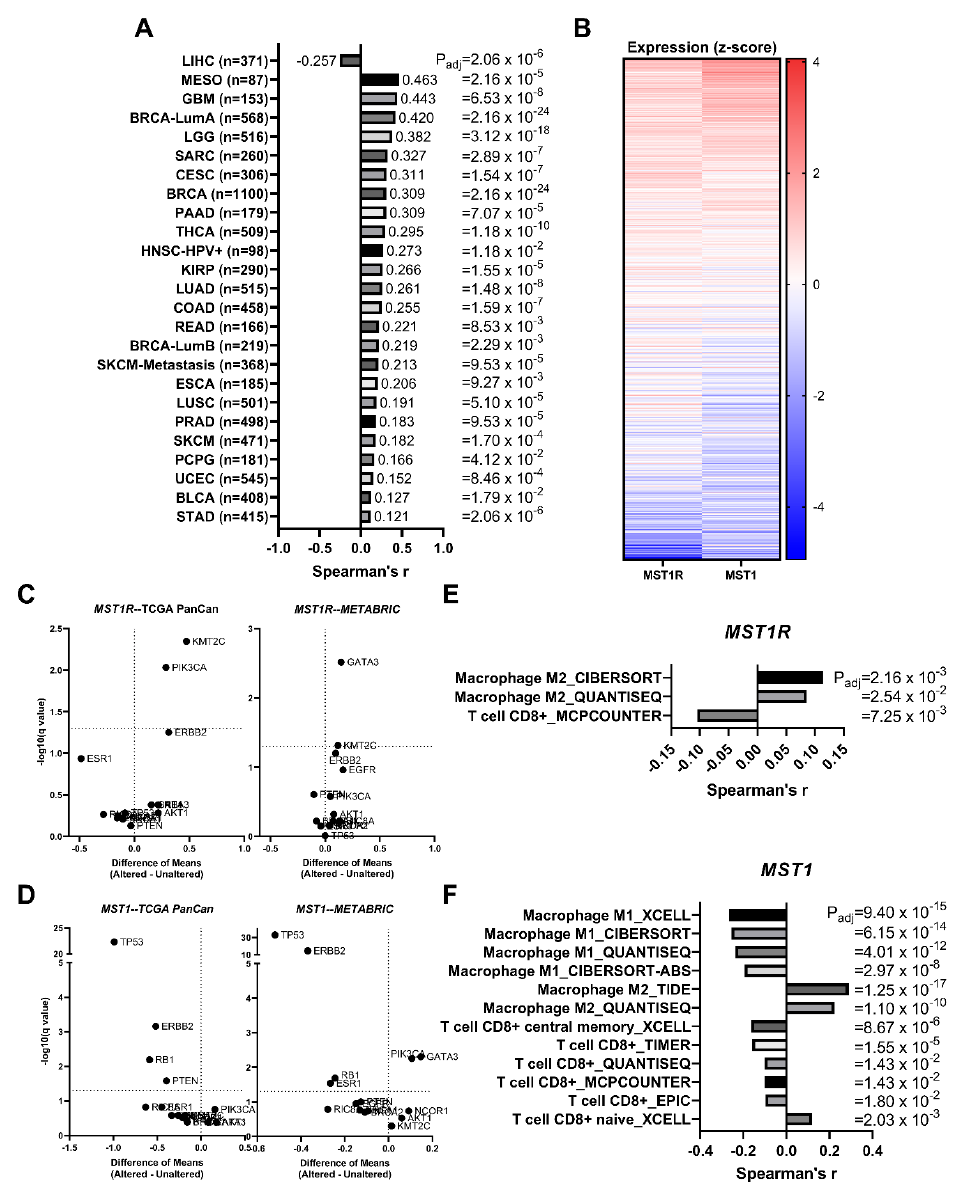
Figure 6. RON ( MST1R ) and HGFL ( MST1 ) expression are correlated in virtually all tumor types and expression is not associated with recurrent breast cancer driver mutations. ( A ) MST1R and MST1 gene expression are coordinately upregulated across specified cancer types from The Cancer Genome Atlas (TCGA) evaluated with Spearman’s correlation. ( B ) MST1R and MST1 RNA expression from TCGA showing coordinate expression in heatmap form. Volcano plots of ( C ) MST1R and ( D ) MST1 RNA expression stratified between Altered and Unaltered samples of listed recurrent breast cancer driver mutations from TCGA Pan-Cancer and METABRIC datasets were evaluated using Multiple t -tests on log-transformed expression values. Significant correlations of specified immune cell infiltration signatures with ( E ) MST1R and ( F ) MST1 gene expression using the tumor immune microenvironment estimation resource (TIMER) in breast cancer data from